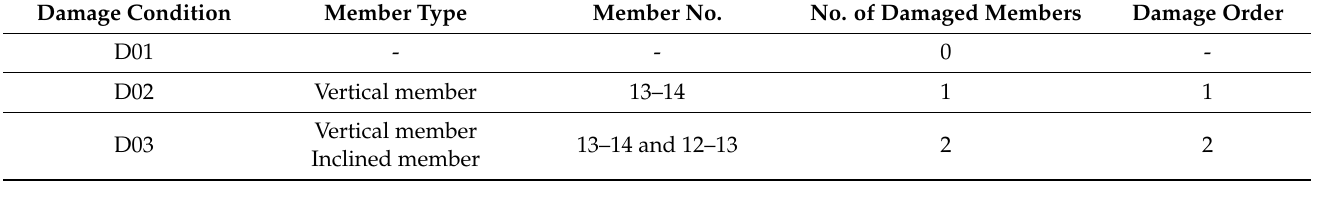
Table 1. Damage conditions.